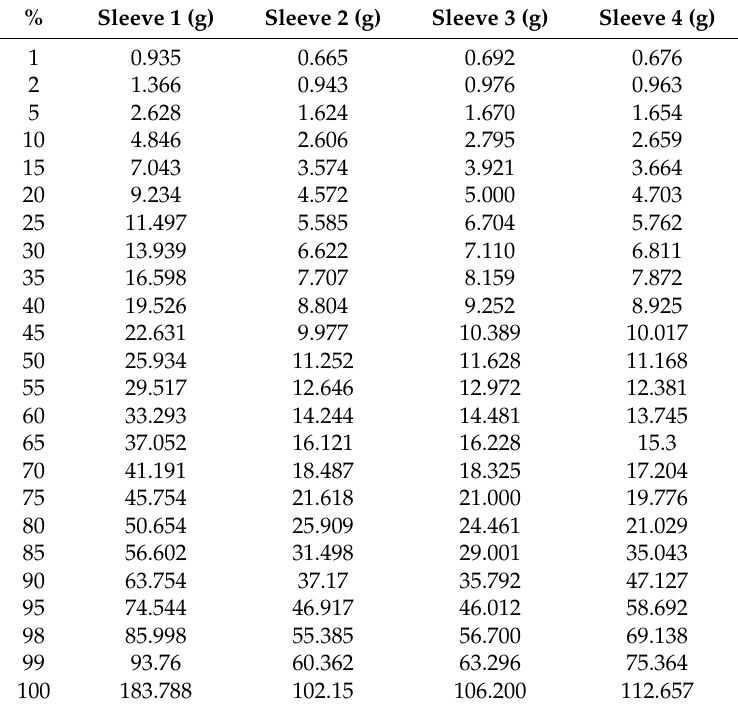
Table 6. Cumulative particle size distribution of SP trapped by filtration cake.